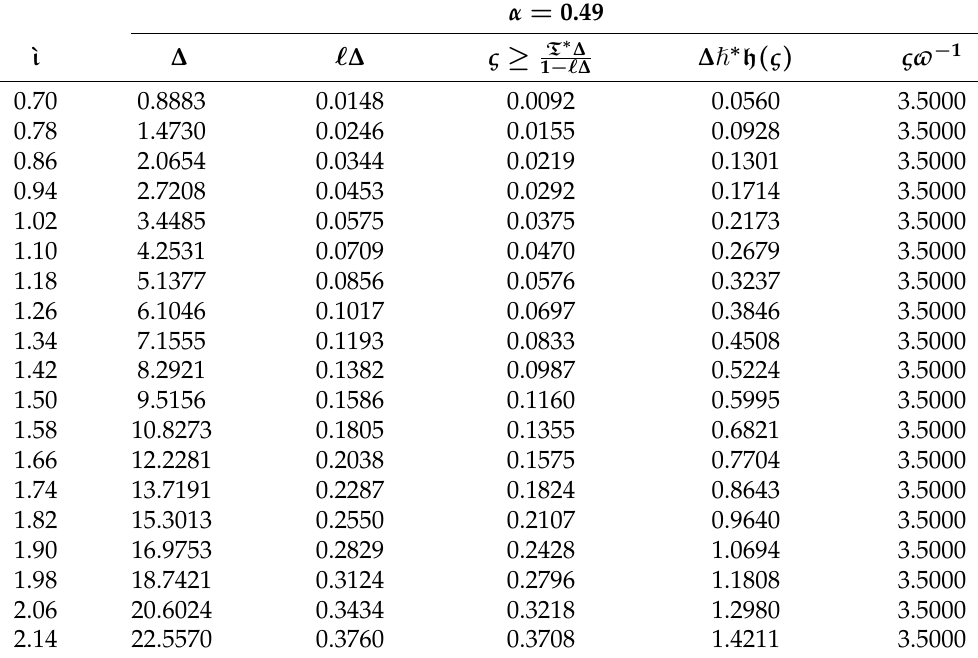
Table 5. Numerical values of ∆ , (cid:96) ∆ , ∆ (cid:125) ∗ h ( ς ) in Example 2 ∀ ` ι ∈ [ 0.7,2.1 ] when G = ` ι and α = 0.49. α = 0.49